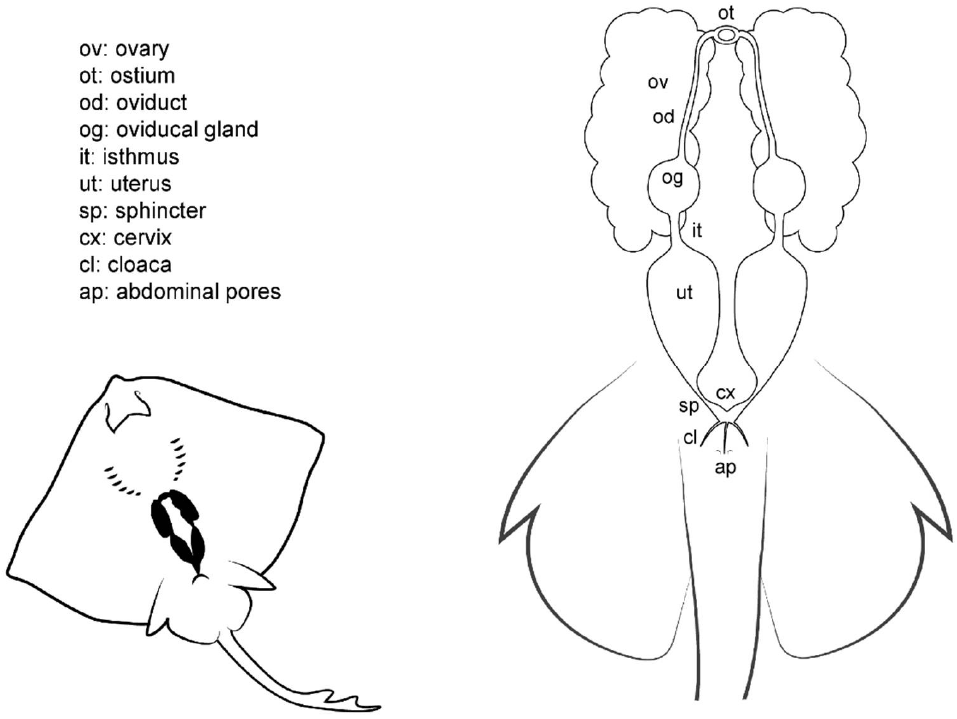
Figure 3. Female general anatomy. Morphological scheme of an ideal batoid female, showing the main reproductive structures: ovaries, oviducts, ostium, oviducal glands, isthmus, uteri, uterine sphincter, cervix, cloaca and abdominal pores.